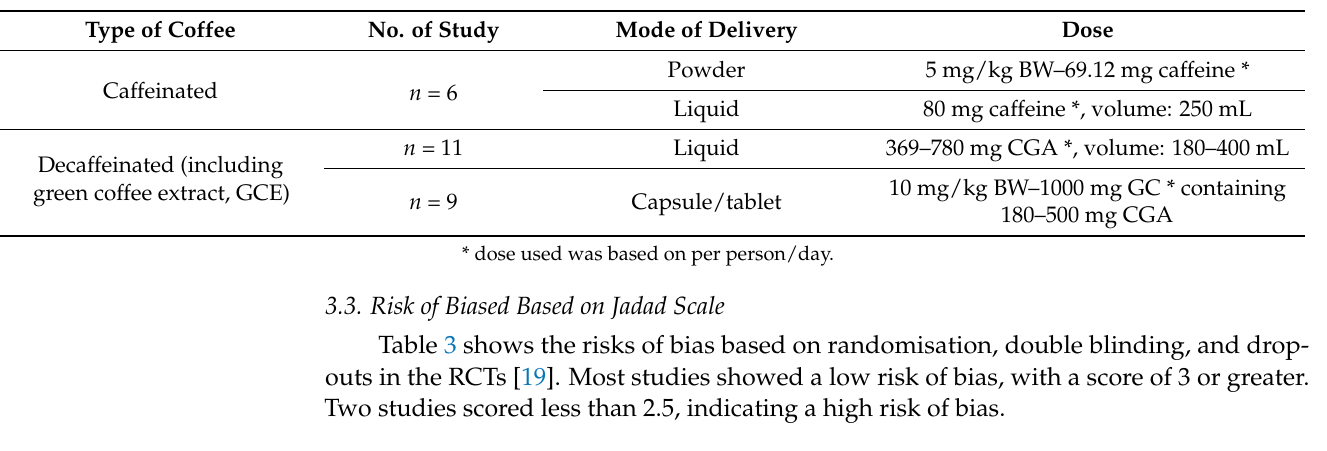
Table 3. Jadad scores of RCTs ( n =